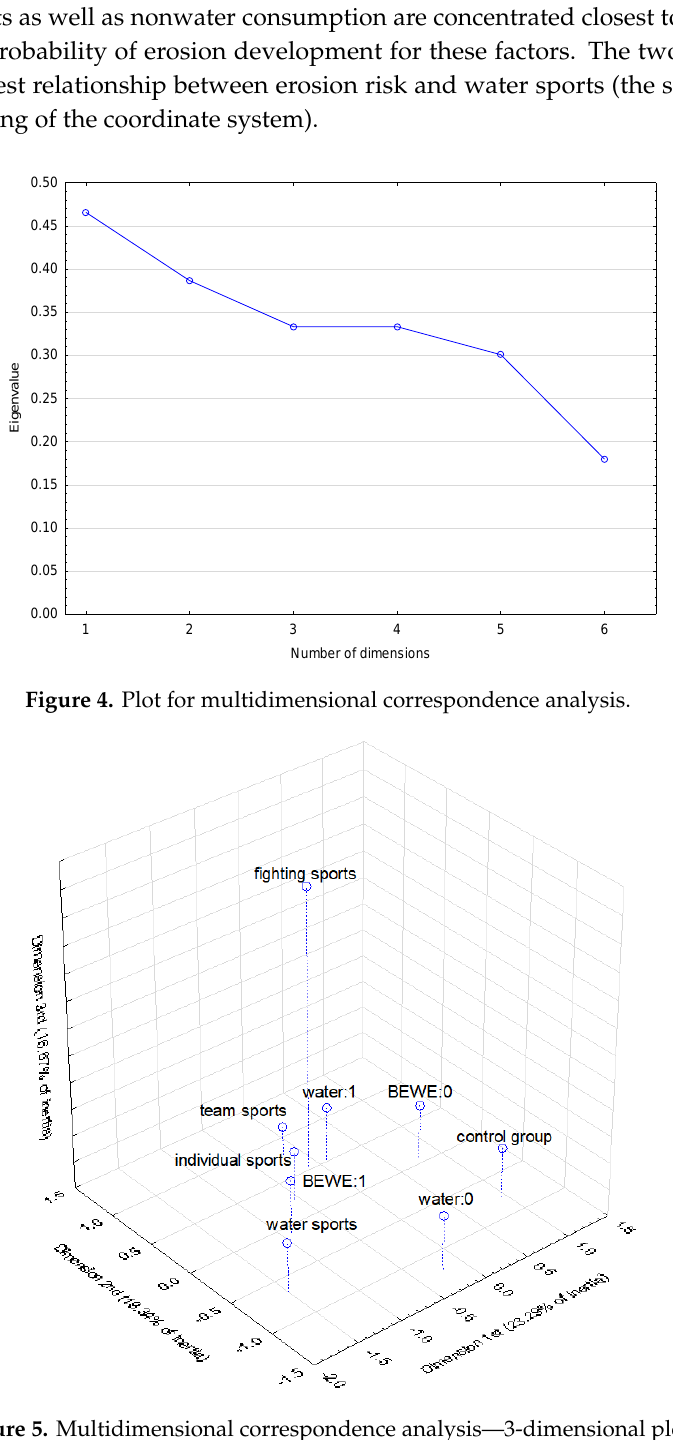
Figure 5. Multidimensional correspondence analysis—3-dimensional plot.